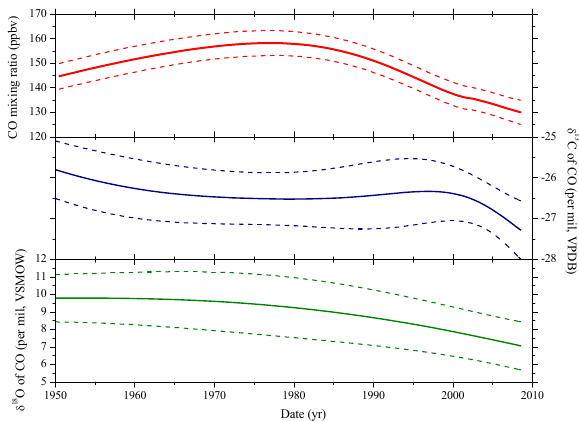
Fig. 3. Best estimate trends of CO concentration (Petrenko et al., 2012) and isotopic ratios simulated by LGGE-GIPSA models of gas transport in firn. Best estimate time trends and uncertainty en- velopes in firn are shown as continuous lines and dashed lines, re-